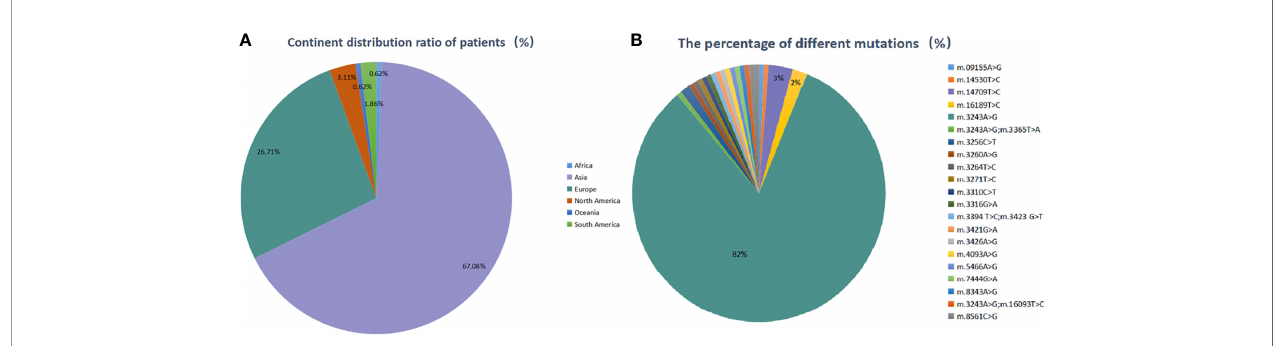
FIGURE 2 | Clinical characteristics of patients with mitochondrial mutations. (A – D) The proportion of several clinical characteristics in enrolled patients: (A) gender (N: 161), (B) family histories (N: 142), (C) treatment (N: 102), and (D) BMI (N: